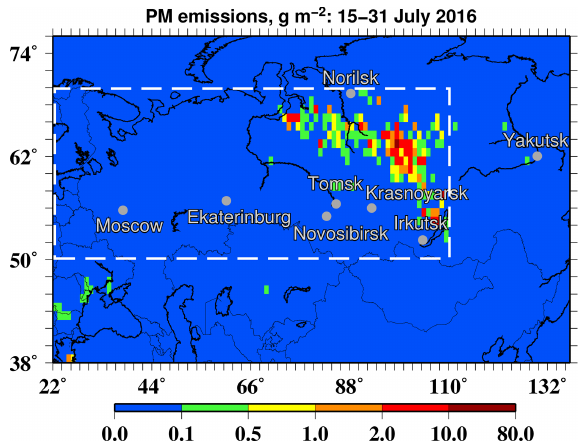
Figure 1. Spatial distribution of the total emissions (gm − 2 ) of par- ticulate matter from fires in the period from 15 to 31 July 2016. The emissions were computed using the MODIS FRP data (see Sect. 2.3) and are shown over the CHIMERE domain specified in this study. A dashed white rectangle indicates the study